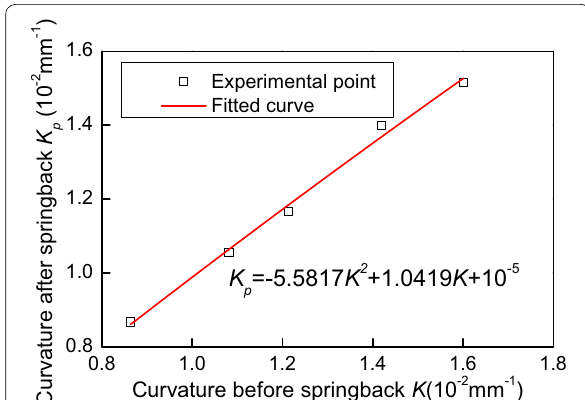
Figure 8 Curvatures of bending parts in V-free bending before and after